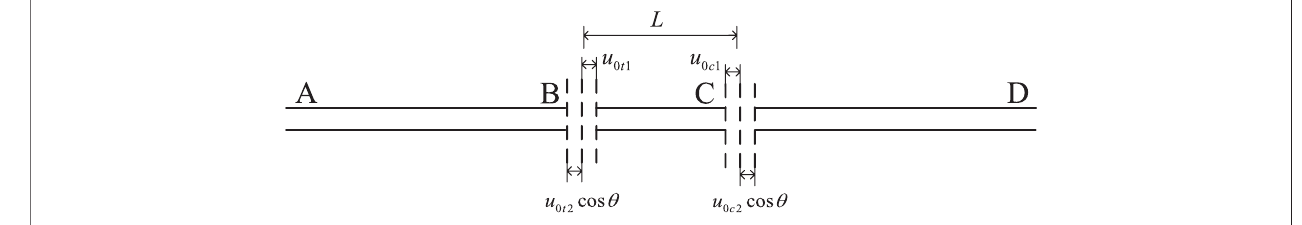
FIGURE 5 | A vertical view of a pipeline longitudinally crossing a thawing landslide slope.